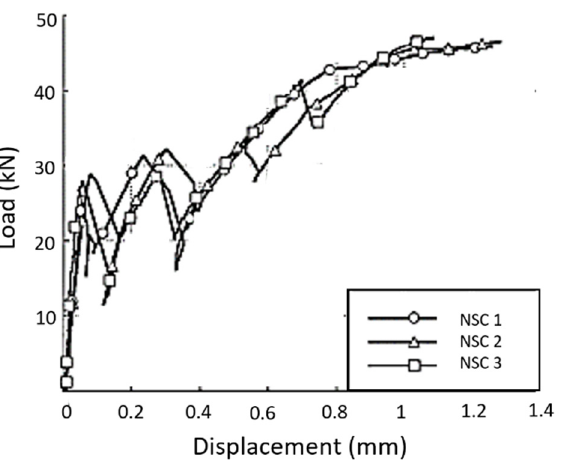
Figure 27. Tensile behavior of three repeated tie specimens of normal strength concrete (NSC) (Adapted with permission from reference [59]).